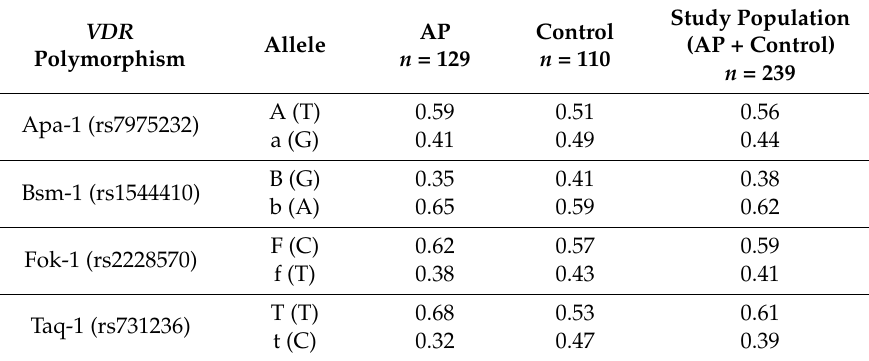
Table 2. VDR SNPs frequency of alleles in the control group and patients with